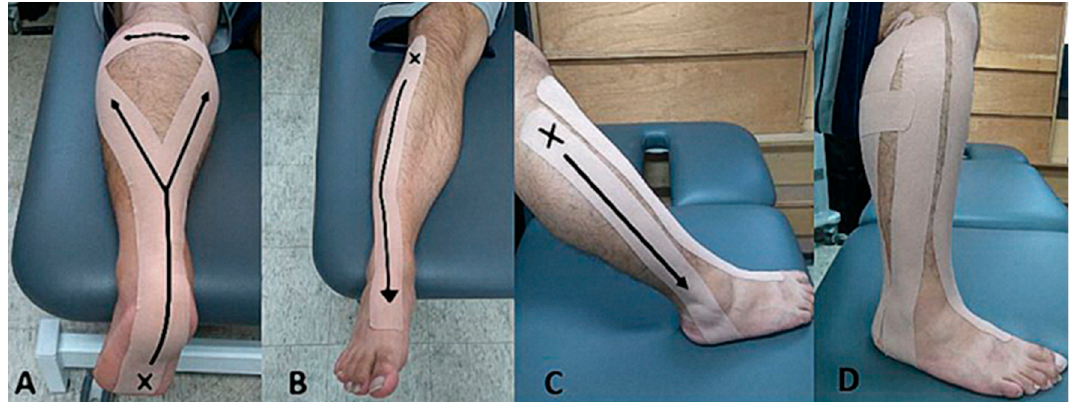
Figure 3. Application of kinesio tape to muscle groups of involved leg: ( A ) gastrocnemius; ( B ) tibialis anterior; ( C ) peroneal longus; and ( D ) overall view. Note that “x” indicates the origin anchor of the kinesio tape and the arrow shows the direction in which the tape is applied.